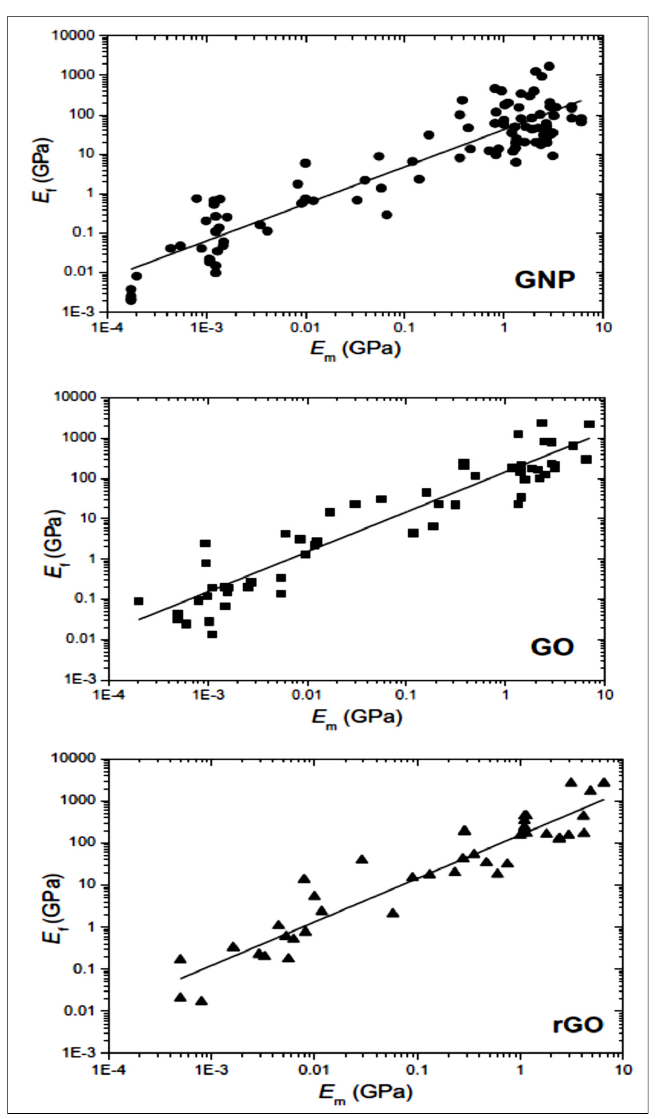
Figure 7. Graphene Young’s modulus as a function of the matrix modulus [35].